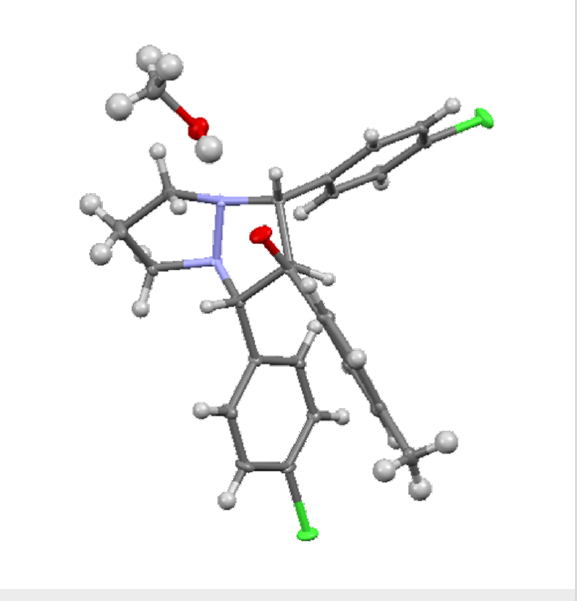
Figure 2: Single-crystal X-ray structure of compound 3g .